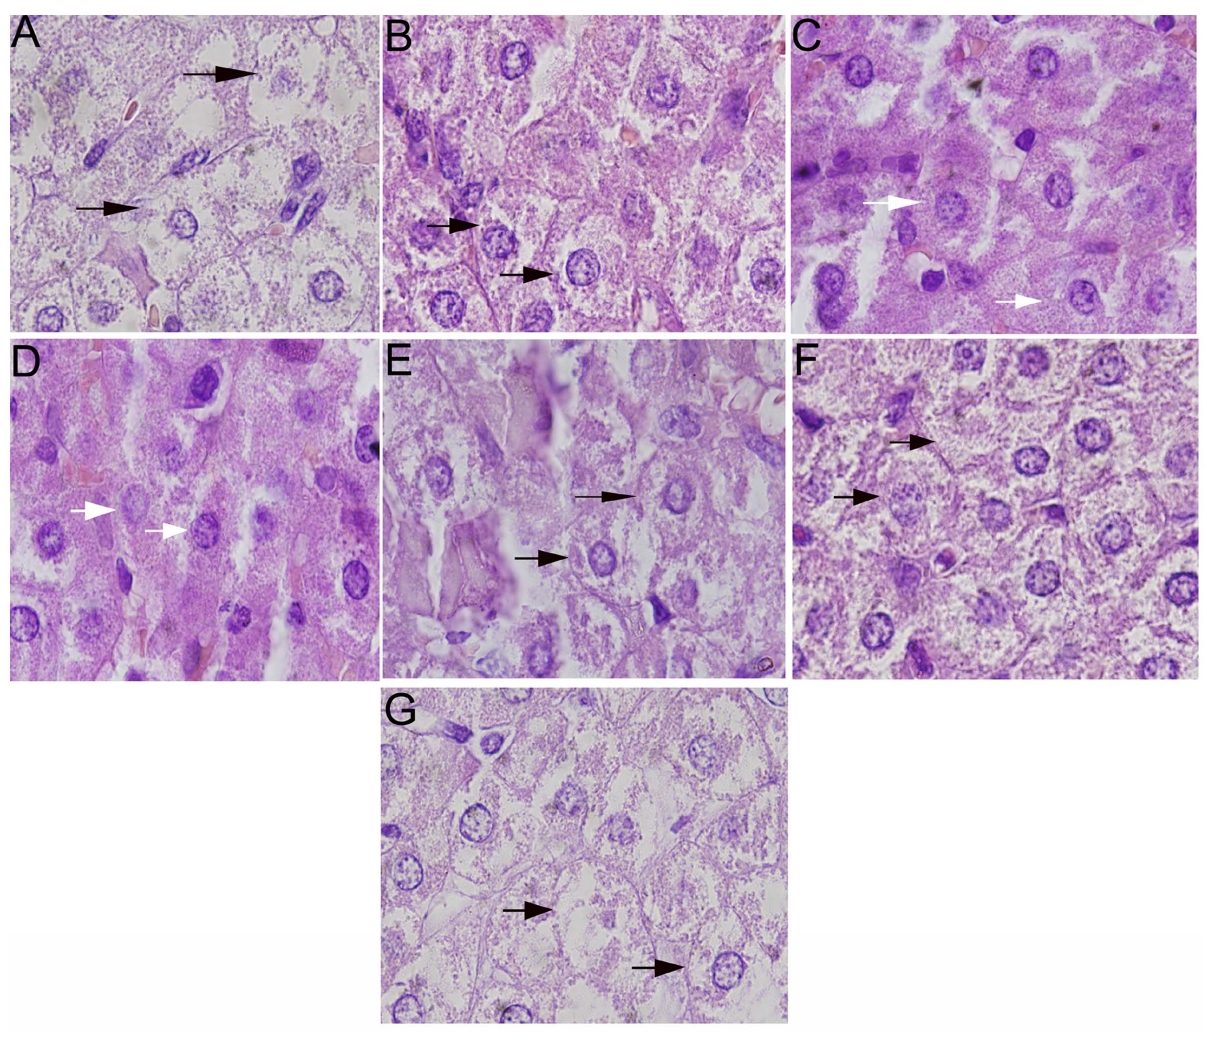
Figure 5. Histopathology of group animals after FMDV challenge. The sections of hepatic tissues from seven groups of guinea pigs were made after animals were sacrificed on day 14 post challenge. The hepatic histological changes in sections of different groups of animals were observed under optical microscope (40 6 ). The black arrows pointed to the typical injured hepatic cells and the white arrows pointed to the typical uninjured hepatic cells. (A) The hepatic histological changes of guinea pigs in PBS group after FMDV challenge. The hepatic cells became swollen and vesicular without well-proportioned cytoplasm after granular degeneration in cytoplasm, and even parts of hepatic cells became vacuoles. (B) The hepatic histological changes of guinea pigs in liposome group after FMDV challenge. The hepatic cells became swollen and parts of hepatic cells developed granular degeneration in cytoplasm. (C) The hepatic histological changes of guinea pigs in peptide I group after FMDV challenge. The hepatic cells aligned regularly with slight inflammatory cell infiltration. (D) The hepatic histological changes of guinea pigs in peptide II group after FMDV challenge. The hepatic cells aligned regularly with slight inflammatory cell infiltration. (E) The hepatic histological changes of guinea pigs in peptide III group after FMDV challenge. The hepatic cells displayed swollen and some of cells developed granular degeneration in cytoplasm. (F) The hepatic histological changes of guinea pigs in peptide IV group after FMDV challenge. Most of hepatic cells became swollen with granular degeneration in cytoplasm. (G) The hepatic histological changes of guinea pigs in peptide V group after FMDV challenge. After granular degeneration in cytoplasm, the hepatic cells became vesicular, and even parts of hepatic cells became vacuoles.